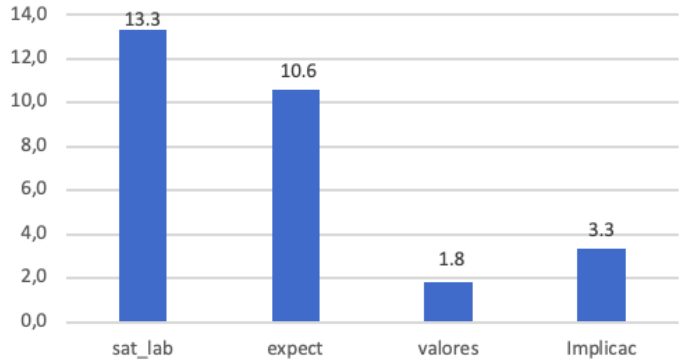
Figure 1. Individual indicators of quality of work life.